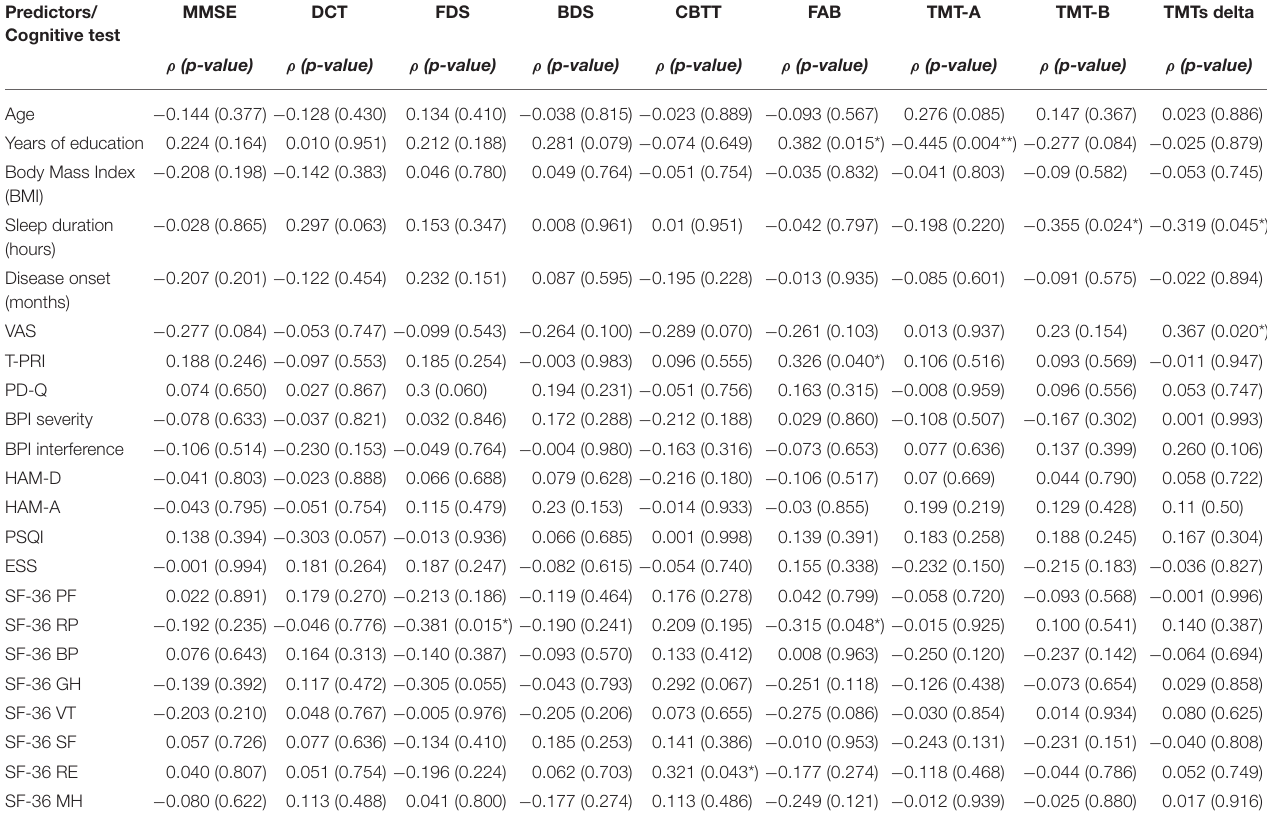
TABLE 8 | Correlation analysis between cognitive tests and quantitative predictors in patients with BMS. Predictors/ Cognitive